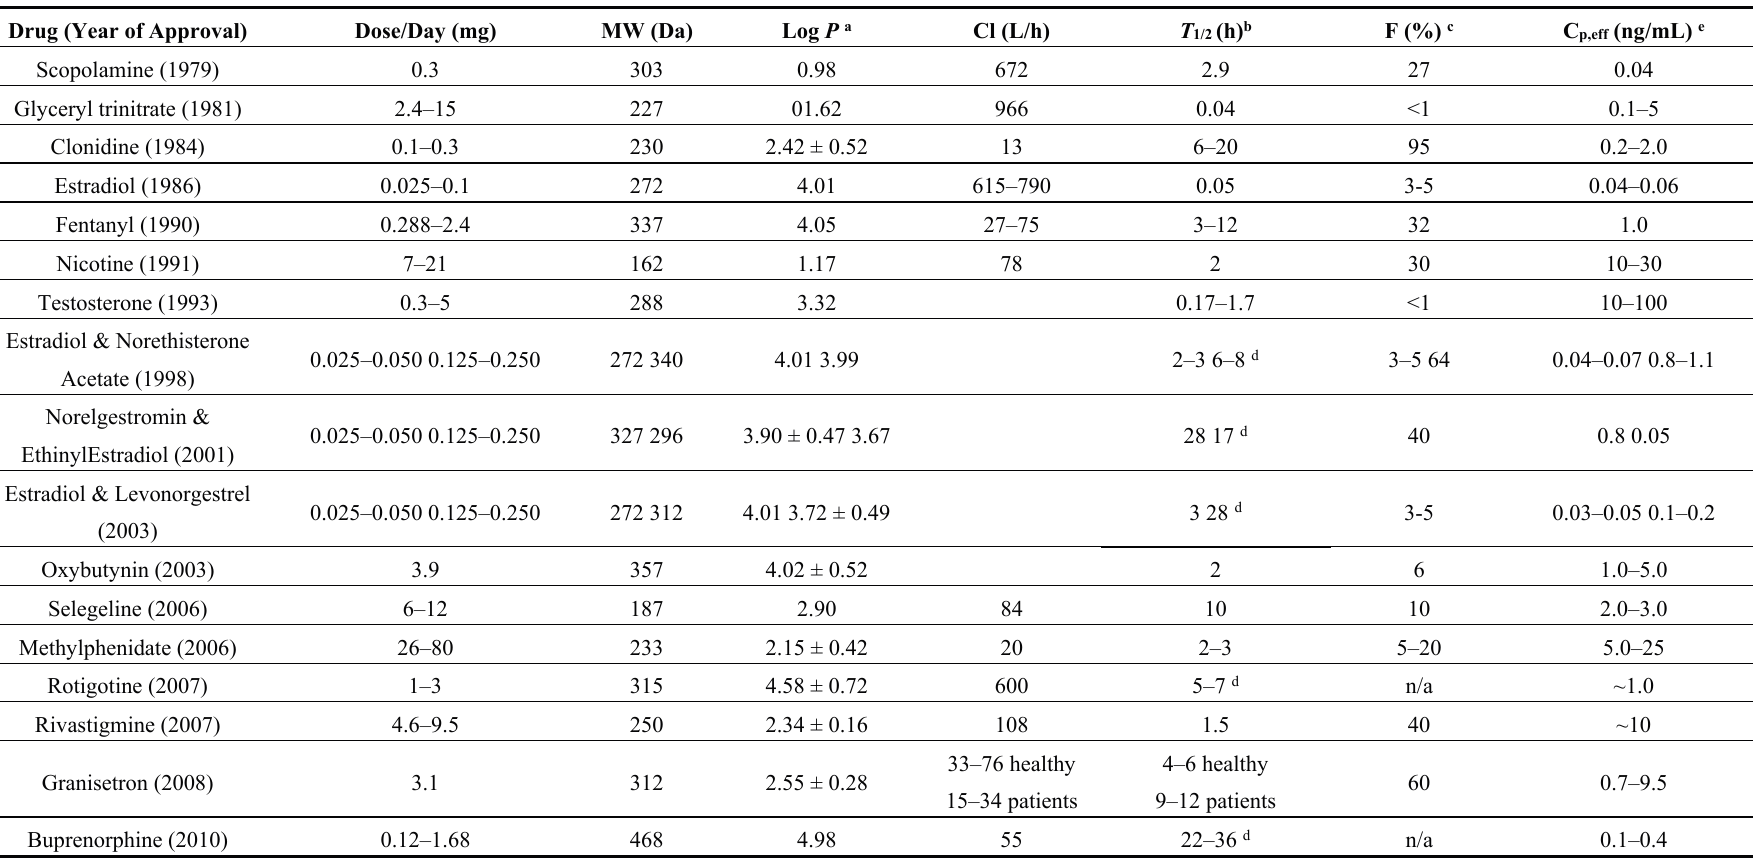
Table 1. Daily dose ranges and selected physicochemical and pharmacokinetic properties of currently approved transdermally delivered drugs. (Reprinted from [34] with permission. Copyright 2014